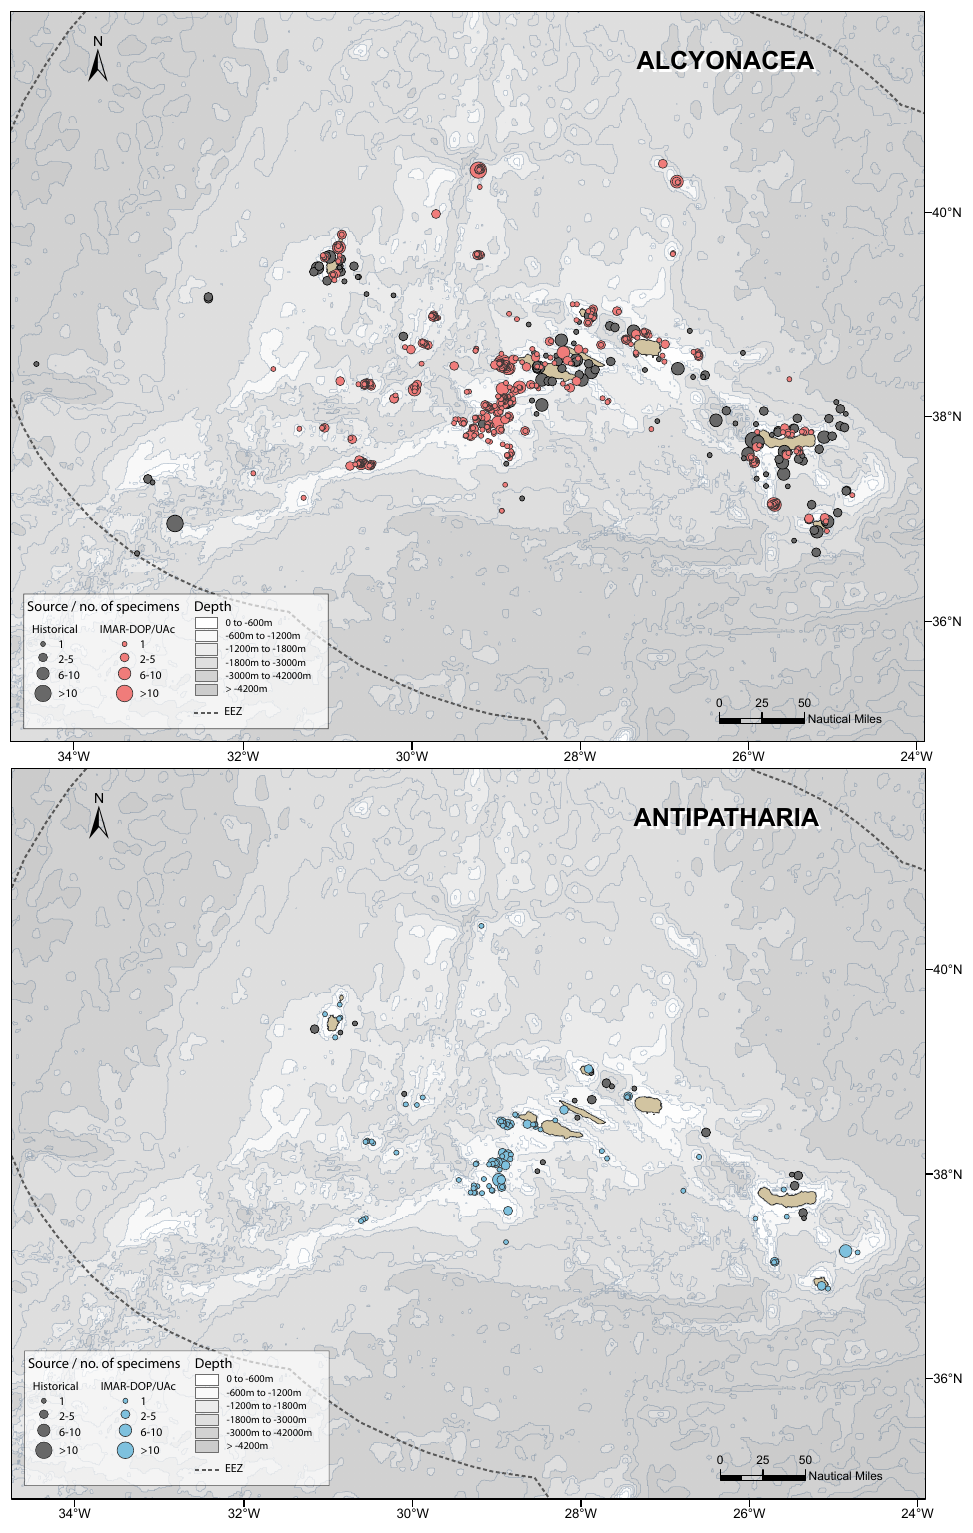
Fig. 3. Distribution of georeferenced coral records per taxonomic group for the Azores EEZ based on major oceanographic expeditions, other coral events and IMAR-DOP/UAc records, from 1869 to 2011. Alcyonacea: 299 historical/829 IMAR-DOP/UAc records; Antipatharia: 31/120; Scleractinia: 417/327; Stylasteridae: